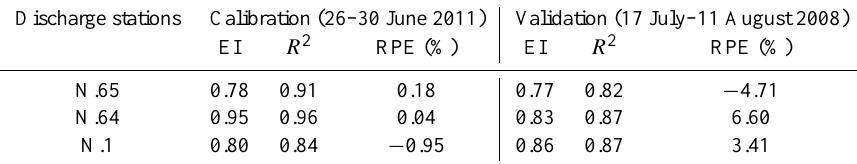
Table 1. Statistical indices indicating performance of the PANTA RHEI model Discharge